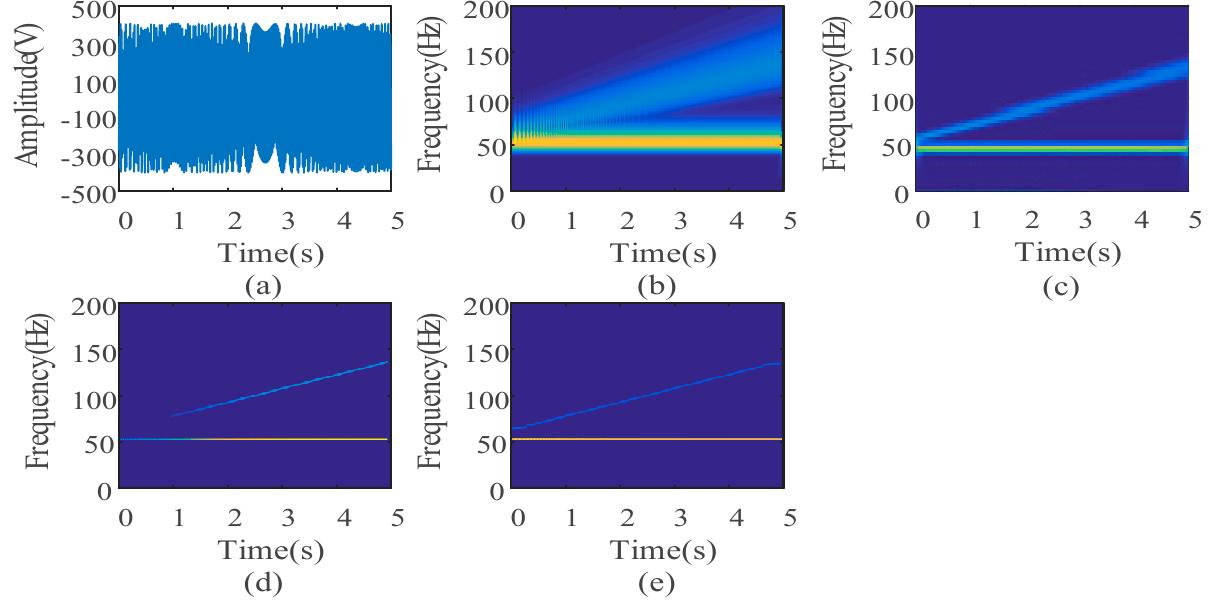
Figure 12. The time-frequency spectra of experimental interharmonic signals based on three methods. ( a ) Time-varying interharmonic signal collected by experiment platform ( b ) S-transform, ( c ) WT, ( d ) synchrosqueezing STFT (SSTFT), ( e ) synchrosqueezing adaptive S-transform (SAST).